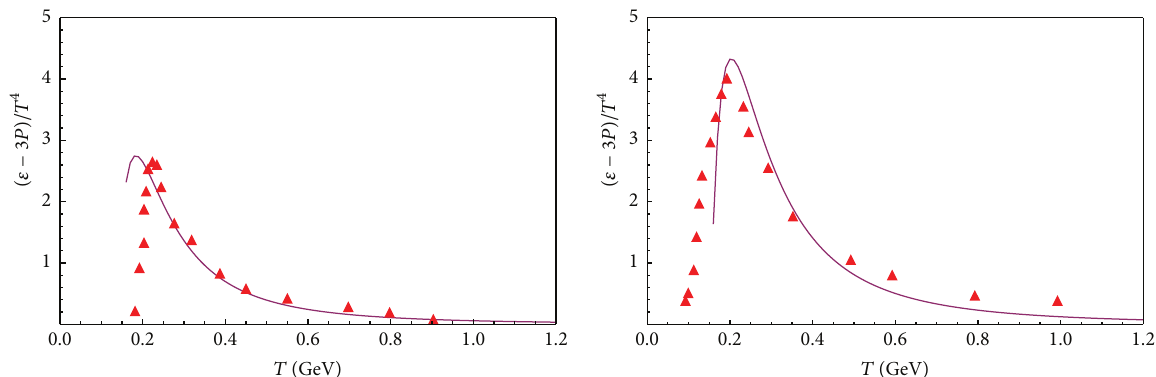
Figure 4: The symbols show the lattice results for the interaction measure in the SU (3) gluodynamics (left panel) [34, 35] and in case of = 2 + 1 QCD equation of state (right panel) [37, 𝑛 𝑓